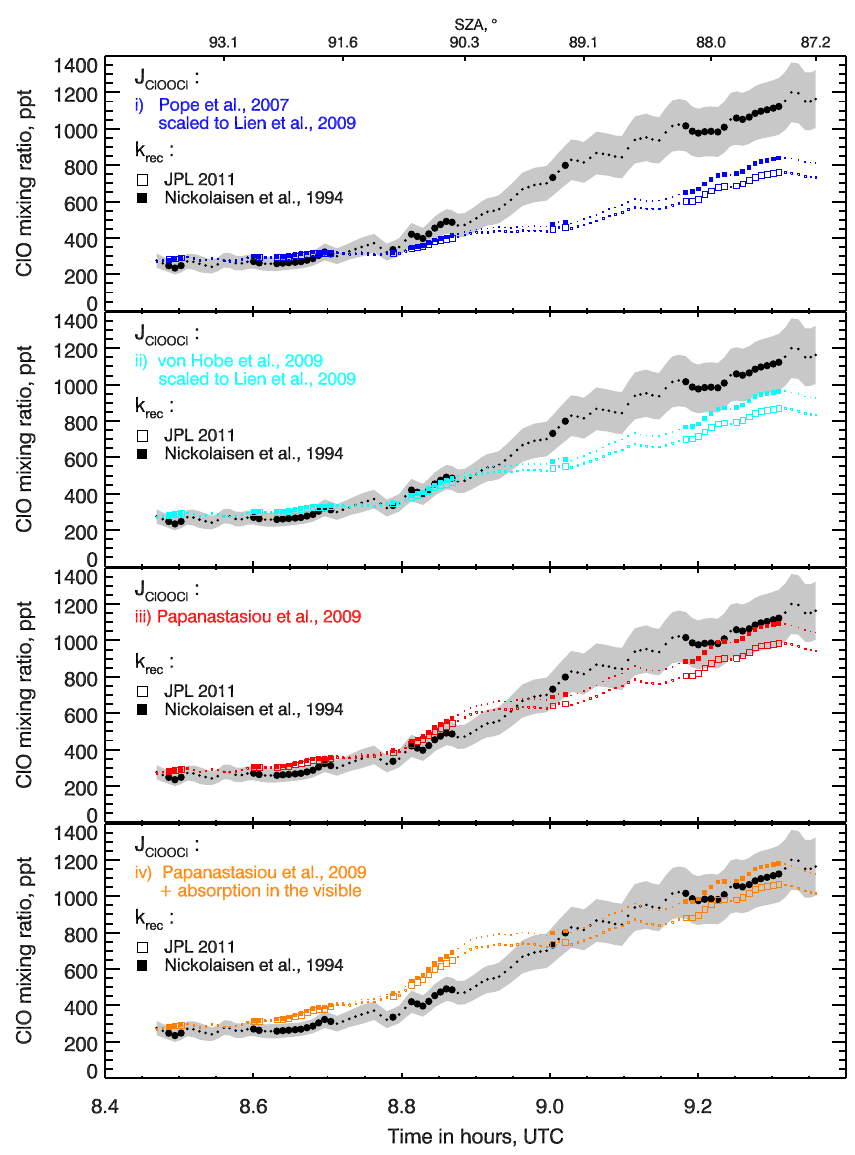
Fig. 9. Comparison of HALOX ClO mixing ratios (black points with grey uncertainty areas) with the results of CLaMS simulations using various combinations of kinetic parameters. The “good matches” are marked by large